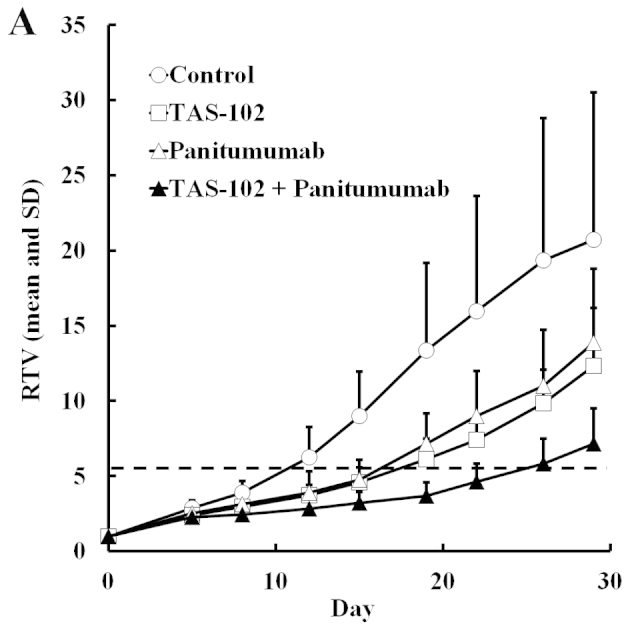
Relative volume change in human SW48 colorectal tumors (A) and body weight change in SW48 tumor-bearing nude mice (B). Mice were treated with vehicle (○), TAS-102 (□), panitumumab (△), or combined TAS-102 and panitumumab (▲). The values indicate the means + SD (n=6). The horizontal dotted line indicates an RTV of 5. RTV, relative tumor volume.